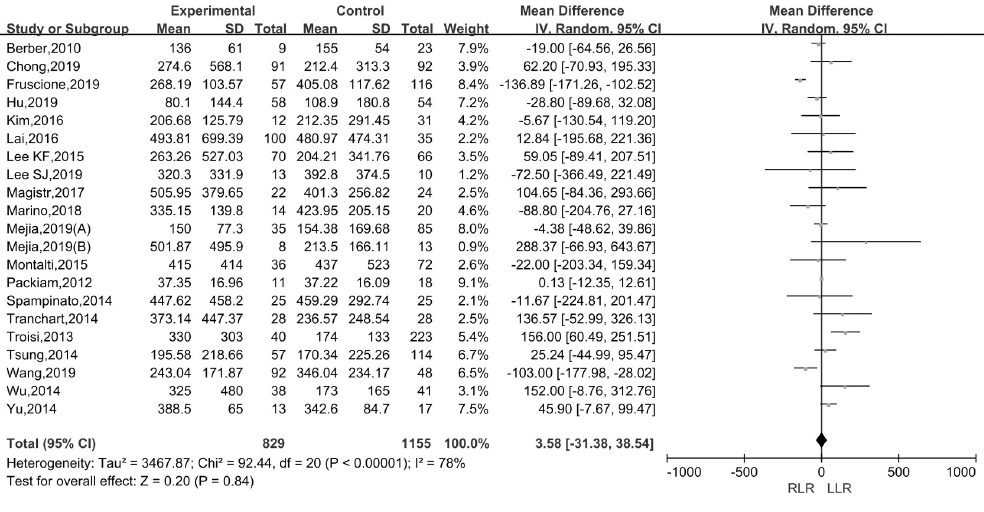
Fig 3. Forest plot of the meta-analysis on estimated blood loss.